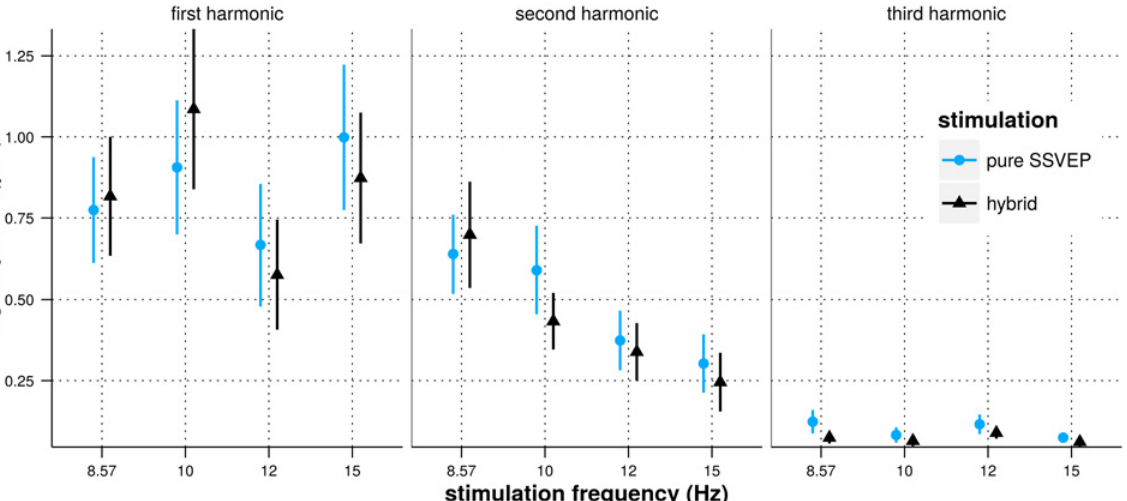
Fig 8. Power of the EEG signal recorded at Oz during the SSVEP stimulation with respect to stimulation frequency and stimulation type. The values are averaged over trials and subjects in every conditions and the bars represent the 95% confidence